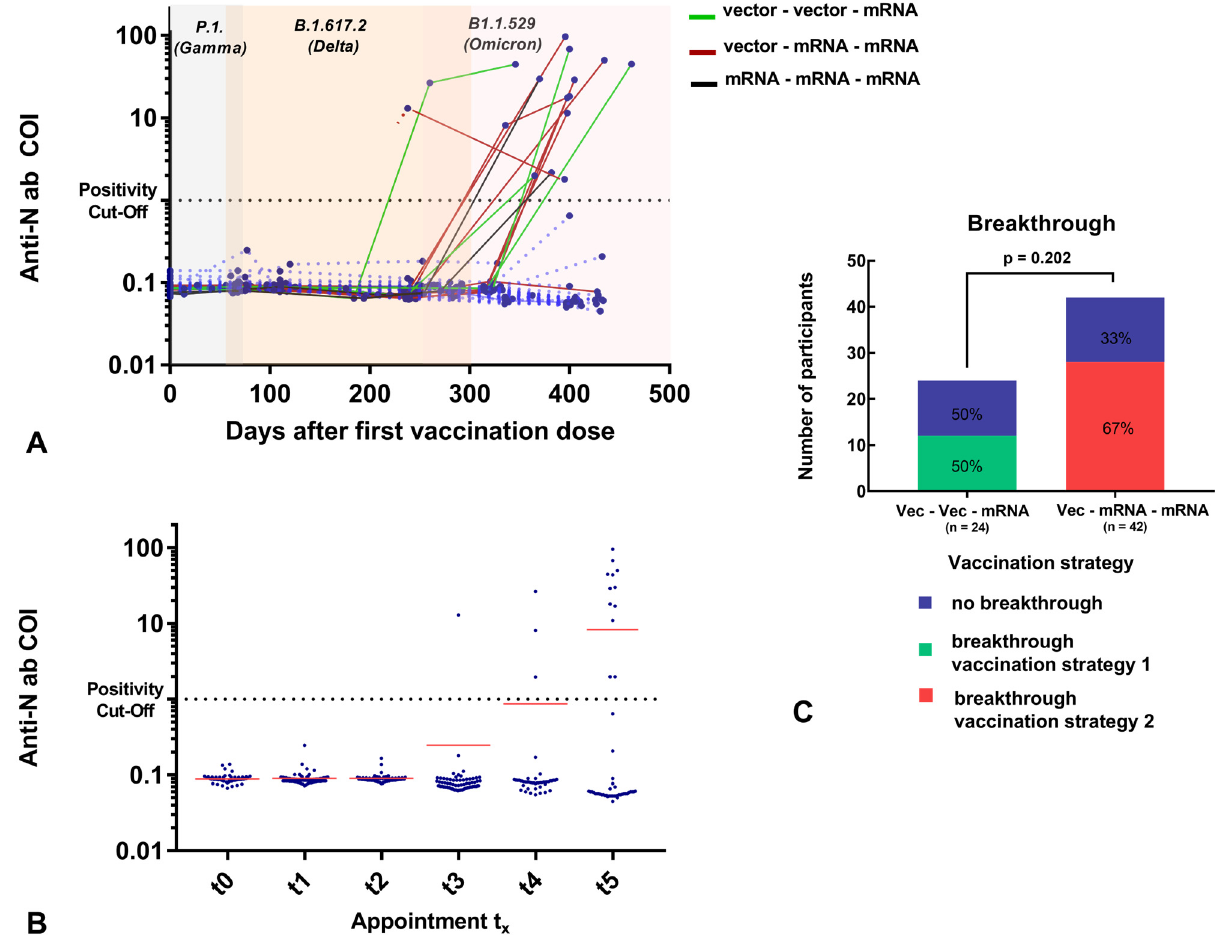
Figure 3. ( A ) Individual anti-N Ig titer (COI; y-axis) related to days after first vaccination (days; x- axis). Two values of one subject (titer of t 0 = 0 days and t 3 =238 days) were not connected due to missing data of t 1 and t 2 , which could imply an earlier ab increase. The variants circulating in the respective period with a chronological overlap are highlighted in color (gray = P1. (Gamma), apricot = B.1.617.2 (Delta), light pink = B1.1.529 (Omicron)). Subjects with vaccination breakthrough before